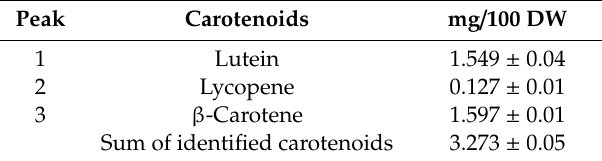
Table 2. Individual carotenoids content of TBE expressed in mg / 100 DW ( β -carotene equivalent). Peak